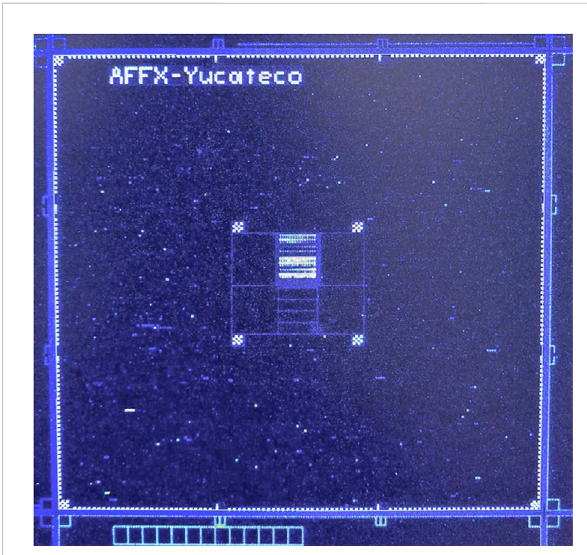
FIGURE 2 Image of the Yucateco array hybridized with the water sample fromthePájaroscenoteinReservaEcológicaElCorchito.Pixelswhere DNA fragments hybridized at the speci fi c probes in the microarray appear in blue and hybridization controls in white.